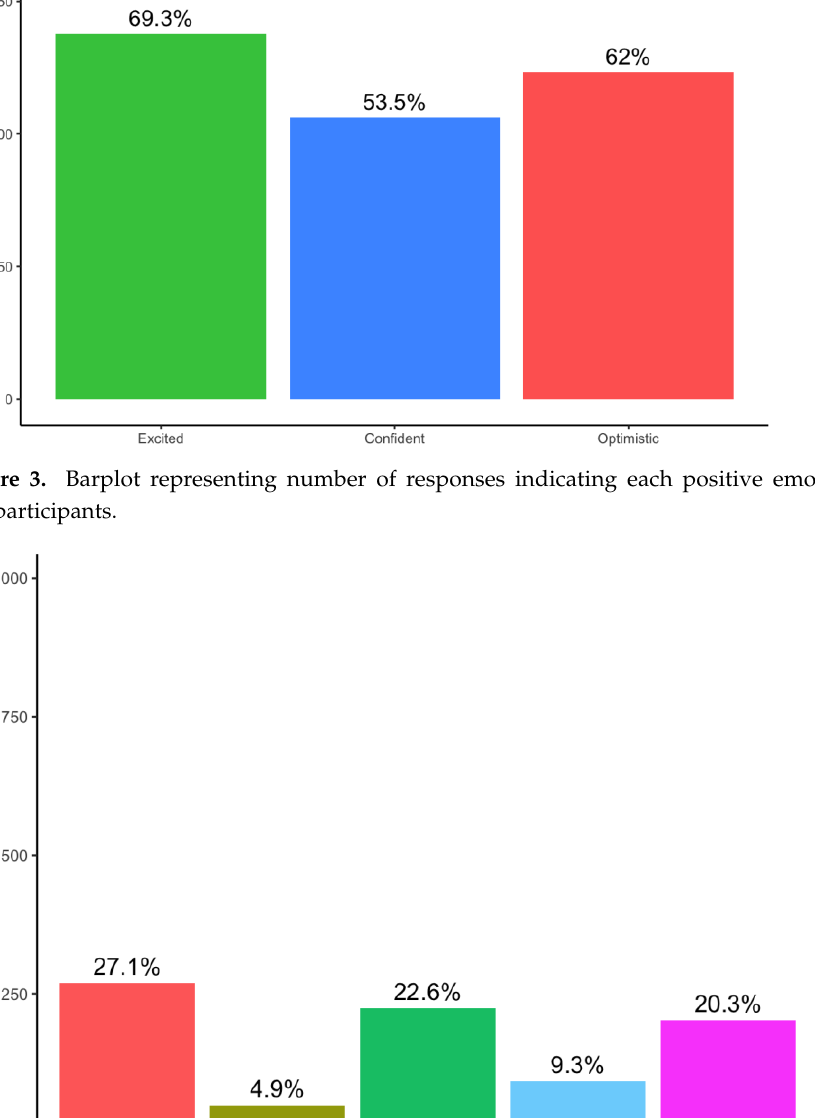
Figure 4. Barplot representing number of responses indicating each negative emotion among 993 participants.